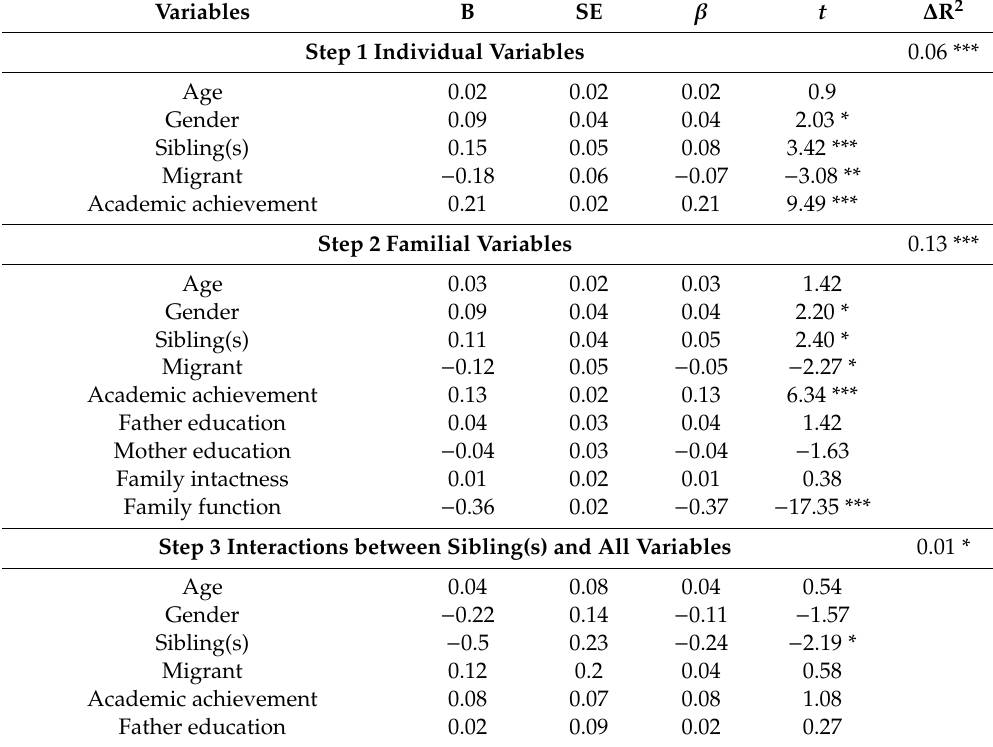
Table 4. Multiple linear regression of various variables on